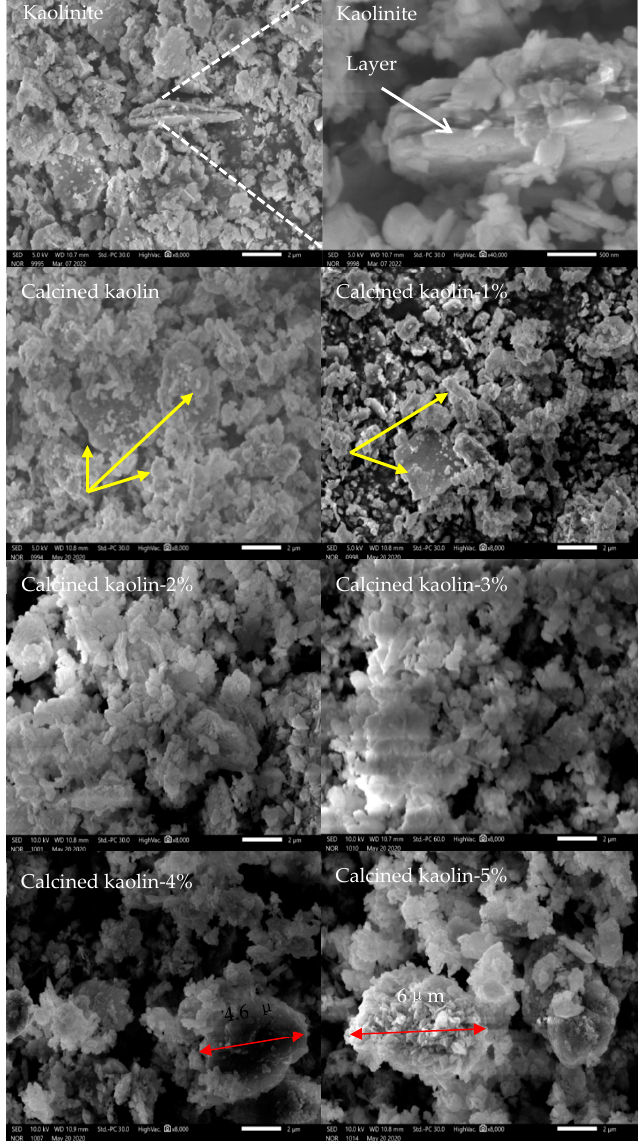
Figure 3. The SEM images of kaolinite, calcined kaolin, and modified calcined kaolins.